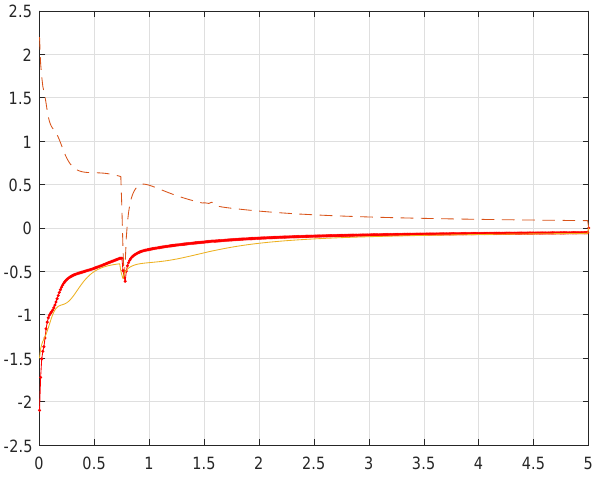
Figure 3. Leader–follower multi-agent system’s error state ω j ( τ )